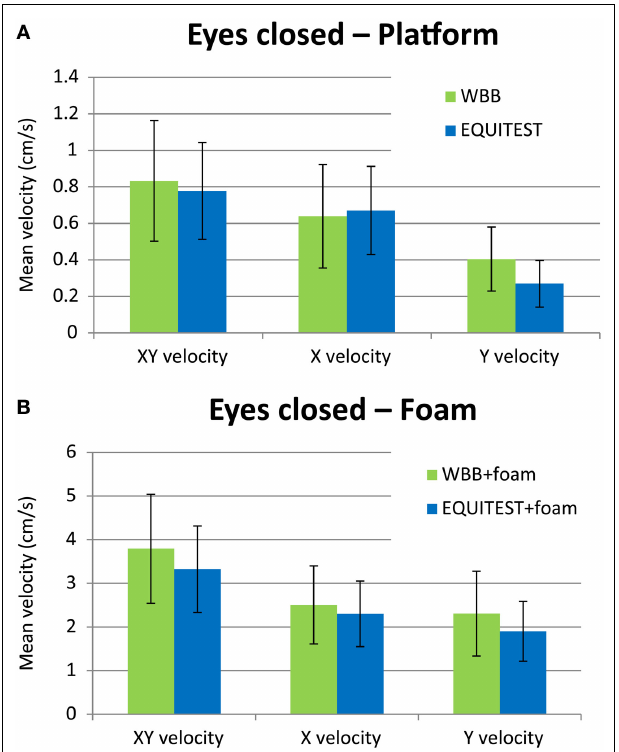
FIGURE 3 | Histogram of the mean XY velocity in condition eyes closed on the WBB (green bars) and on the Equitest platform (blue bars) without foam (A) and with foam (B) . The error bars show the SD. Note that (B) has a much larger vertical scale than (A) , because of the larger deviations in posture when standing on